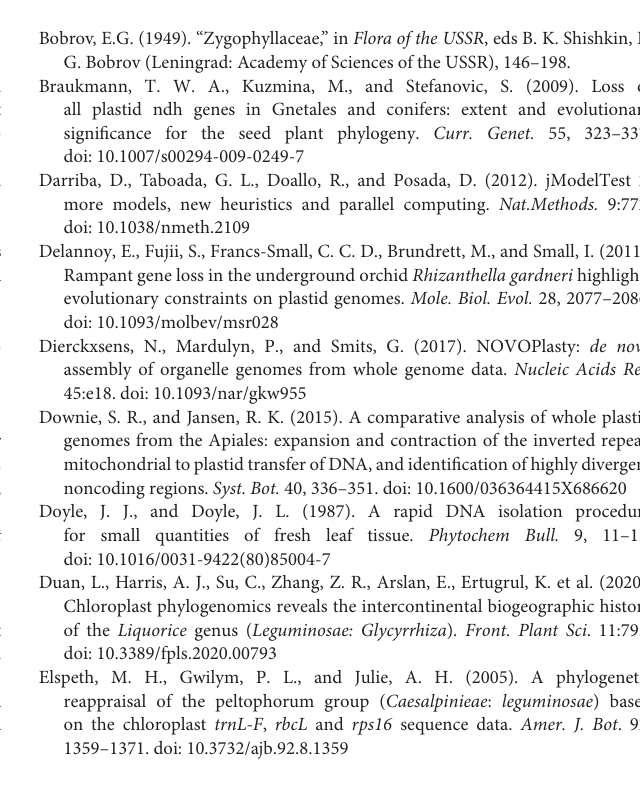
Supplementary Figure 6 | Phylogenetic tree constructed using Maximum Likelihood (ML) IR sequences from different species. Supplementary Table 1 | Information of reported chloroplast genomes in outgroup